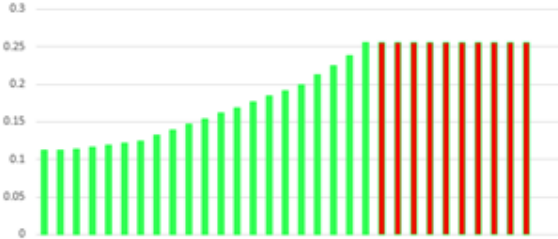
Along the crossing street cloud there is no overlap with the main cloud and consequently it is not possible to apply the method (red dots, Figure 9). In the remaining points of the trajectory of the crossing street cloud, outside the overlapping limit, we decide to apply the correction corresponding to the last overlapping point (Figure 10).